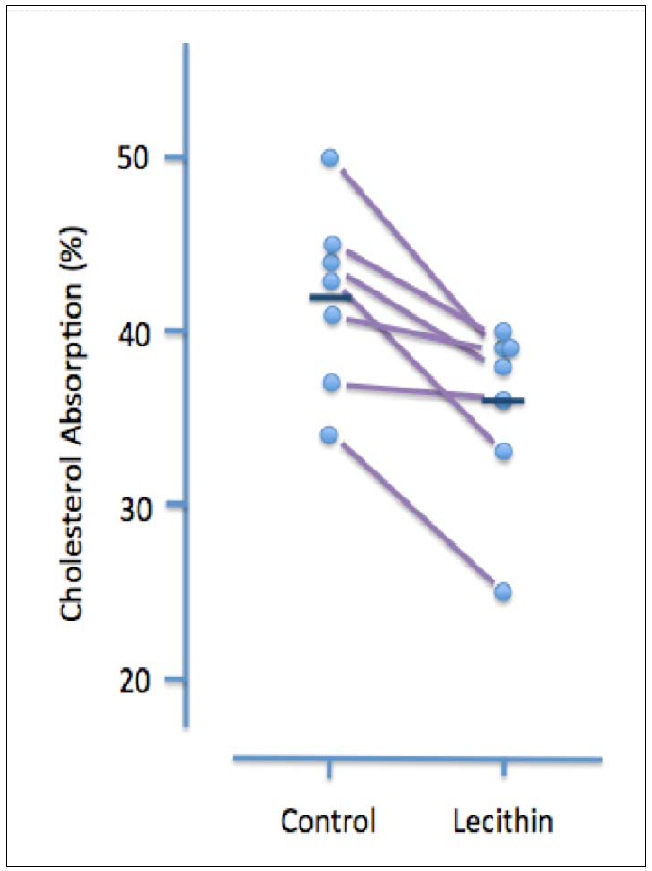
Figure 2. Effect of dietary lecithin (polyenylphosphatidylcholine, 10 grams/day) on cholesterol absorption in hypertriglyceridemic patients. Data are shown for individual patients. During Period I patients were given 7 grams/day of safflower oil and during Period 2 they were given 10 grams/day lecithin (one dose each morning). The amount and composition of fatty acids was equivalent for the two treatments. Cholesterol absorption was measured after two or three weeks by monitoring the ratio of [ 14 C] cholesterol to [ 3 H] b-sitosterol in stools of patients given oral radioactive sterols. Mean cholesterol absorption (shown by the dark horizontal line) during the control period was 42 ± 2% and during the lecithin treatment period was 36 ± 2%. (reproduced from ref.